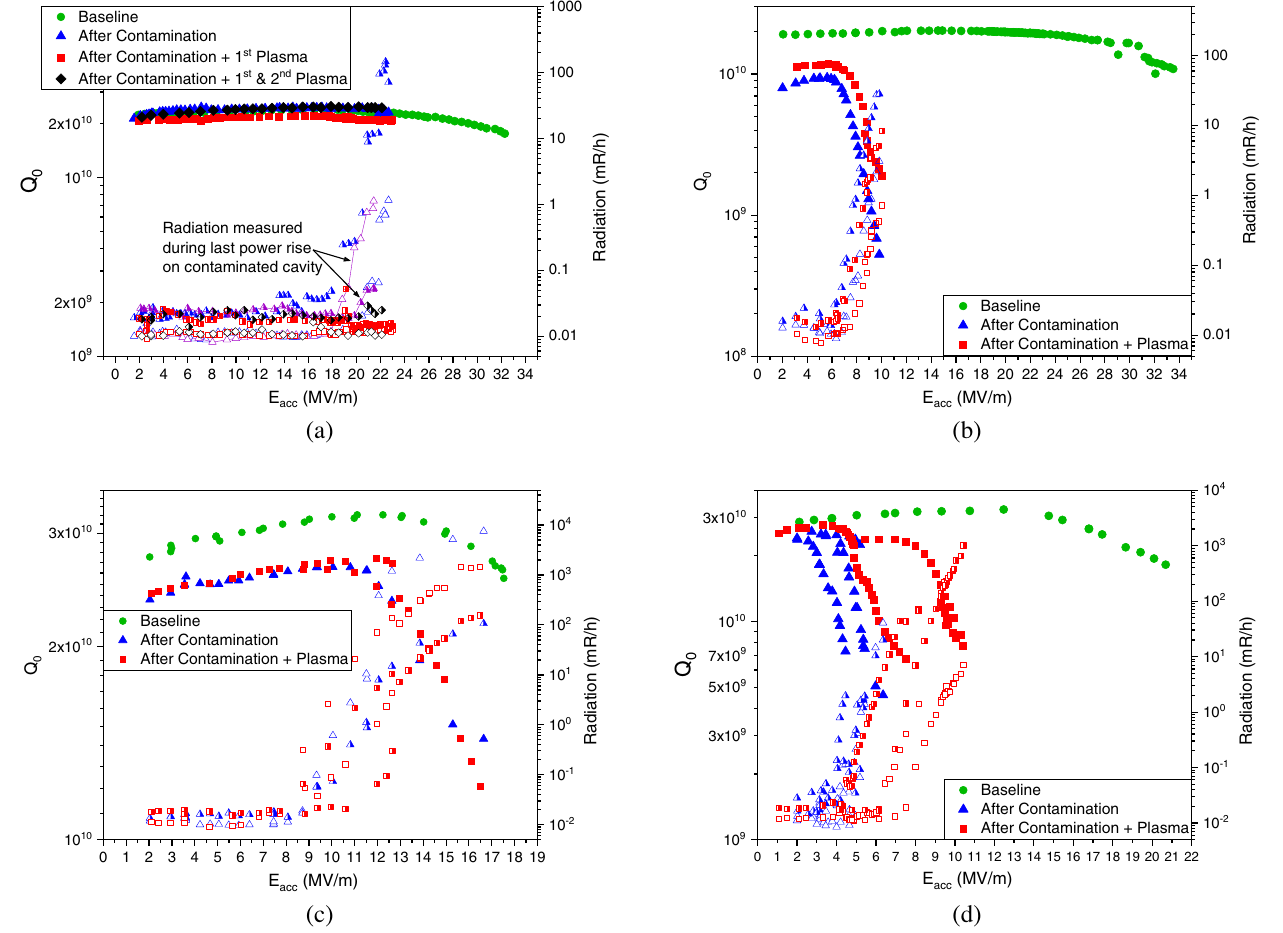
FIG. 10. Vacuum failure experiments simulated on four cavities. Part (a) shows the curves of the nine-cell cavity vented in the cleanroom; the results of the cold test performed after the cavity was contaminated are plotted in blue; the final radiation curves were acquired during this test at 1.4 K: they are plotted with a solid line and purple triangles (empty triangles for the top radiation detector, half-filled for the bottom detector). This cavity was plasma processed twice: the cold test conducted after the first round of plasma cleaning is plotted in red, and in black is the cold test performed after the second plasma round. Part (b) contains the rf tests of the single- cell cavity vented outside the cleanroom through the RAV (right angle valve); both rf tests (after the contamination and subsequently after the plasma test) were stopped at 10 MV = m before quenching; part (c) shows the results of the nine-cell cavity quickly vented through the mini RAV; plot (d) contains the curves of the nine-cell cavity slowly vented through the mini RAV. For comparison all the plots also contain the baseline curves of the cavities, measured before they were exposed to the vacuum failure simulations. Solid symbols are used to plot the Q 0 vs E curve, with empty symbols for the radiation detected from the top detector, and half-filled acc symbols for the bottom radiation